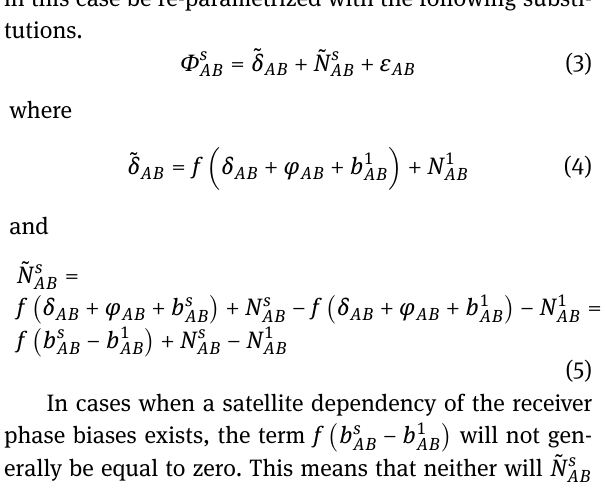
where A , B ∈ { J 1, J 2, J 3, T 1, T 2, T 3, S 1, S 2 } , A ≠ B , ac- cording to Table